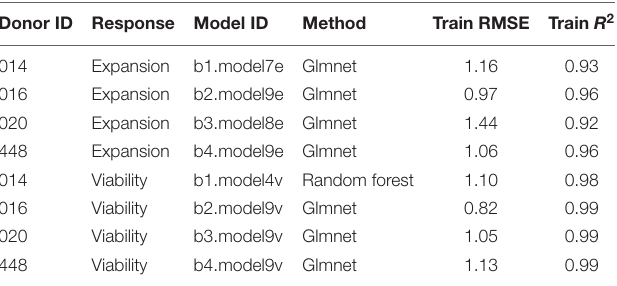
TABLE 1 | Final model and its performance on the train set for each response and each donor.